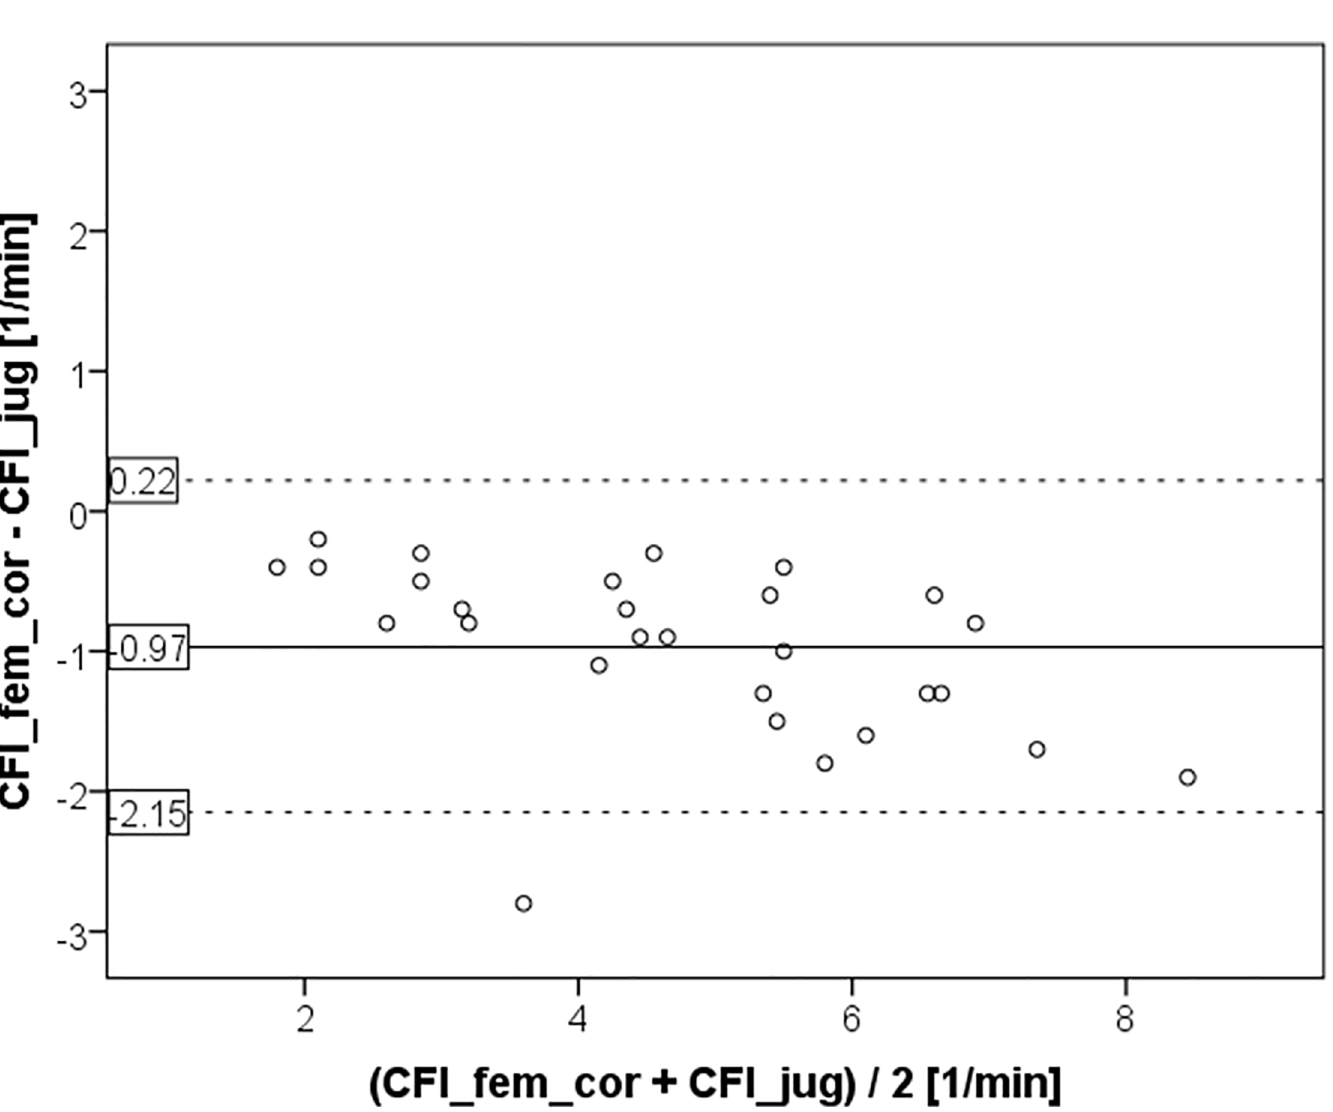
Fig 3. Bland Altman plot comparing cardiac function index CFI_fem_cor derived from femoral injection after activiation of a potential correction by the device to the gold standard measurement CFI_jug using a jugular CVC for indicator injection.